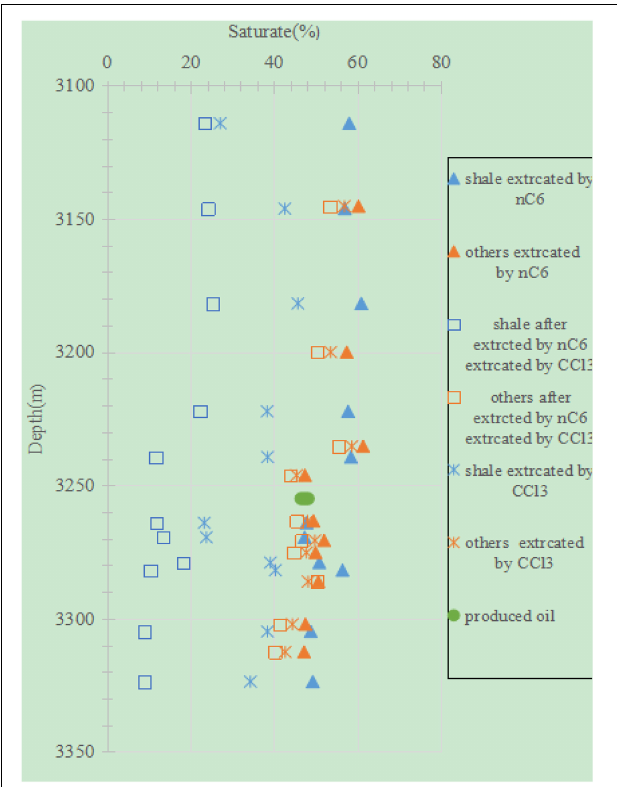
FIGURE 1 | Depth profile of the extract contents of the saturated hydrocarbon from the mud shale versus the non-mud shale after the different extraction